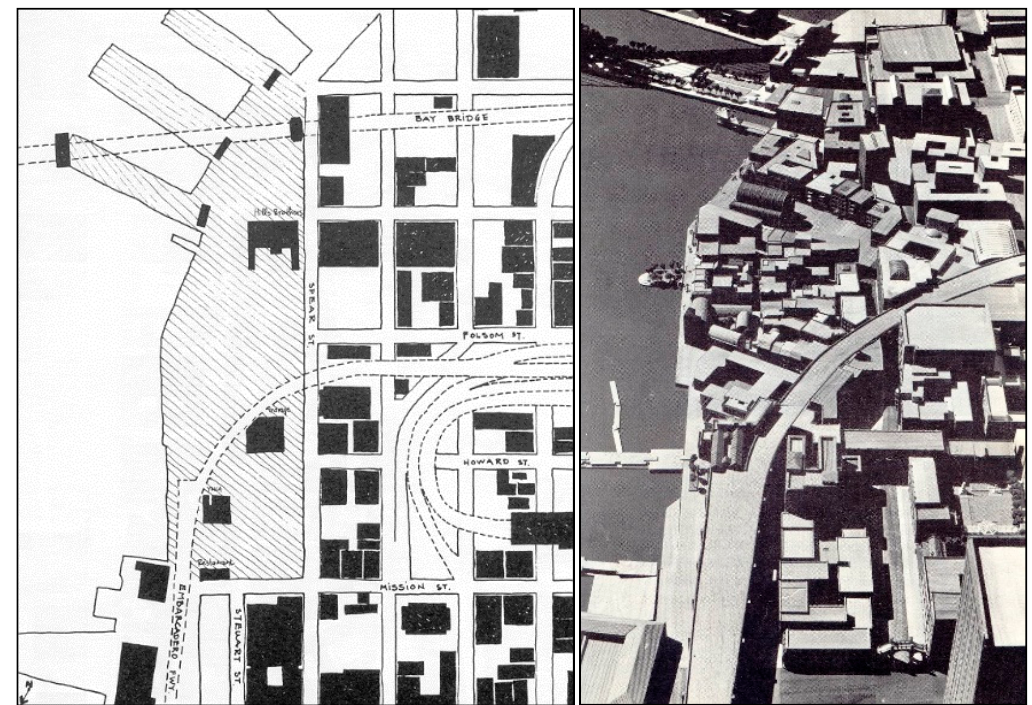
Figure 3. Left: San Francisco waterfront, with the site to be developed marked by hatched lines; Right: photograph of a wooden model of the San Francisco waterfront project after 89 projects; copyright 1987 Christopher Alexander and used with permission [7] (p. 104, p. 107).